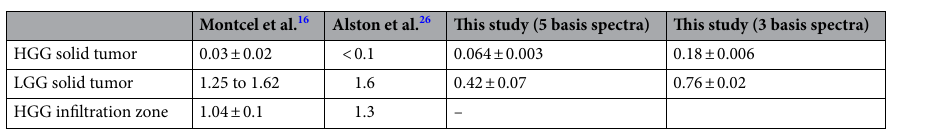
Table 3. Comparison of average Ratio 620/634 values from literature to our results, with and without the lipofuscin and flavin autofluorescence basis